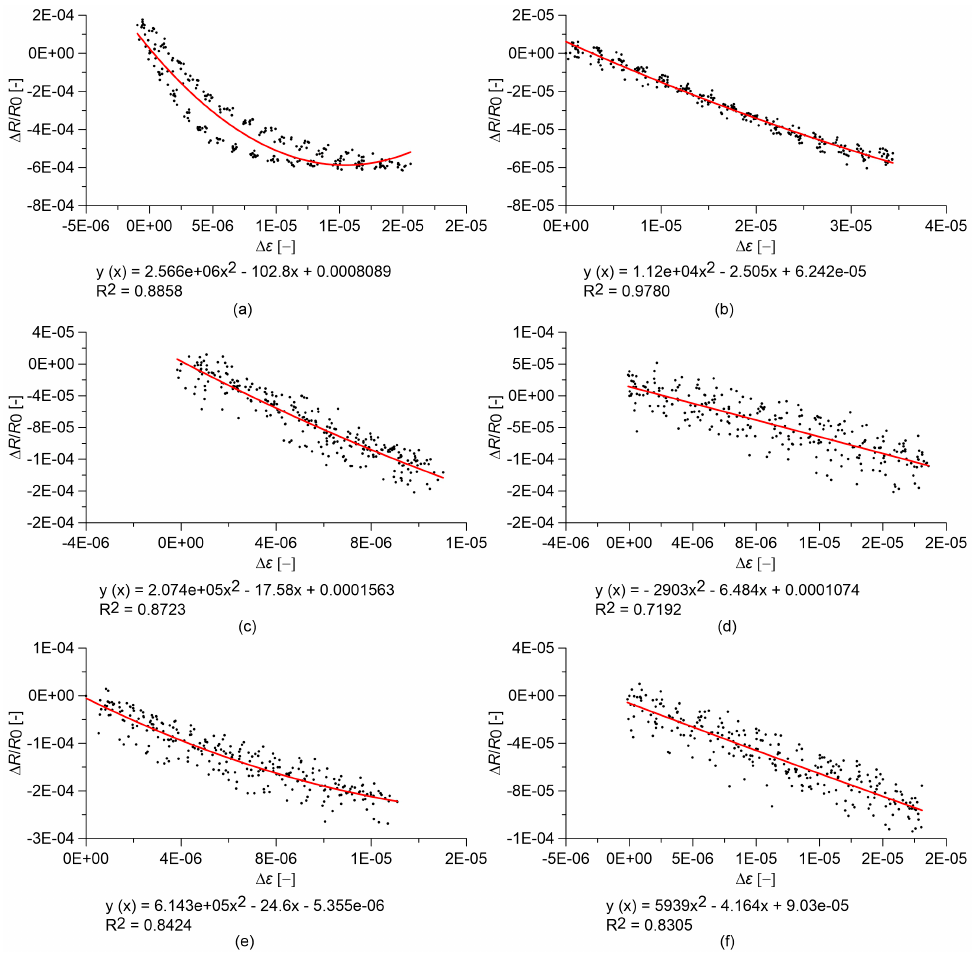
Figure 6. Relative change in electrical resistance versus applied strain of nanocomposite concrete specimens under quasi-static compression loads. In the plots, R 0 is the electrical resistance value with a preload of 0.5 kN, and equations of quadratic regression lines are reported: concrete with ( a ) 0.00% MWCNTs; ( b ) 0.25% MWCNTs; ( c ) 0.50% MWCNTs; ( d ) 0.75% MWCNTs; ( e ) 1.00% MWCNTs; ( f ) 1.50% MWCNTs.